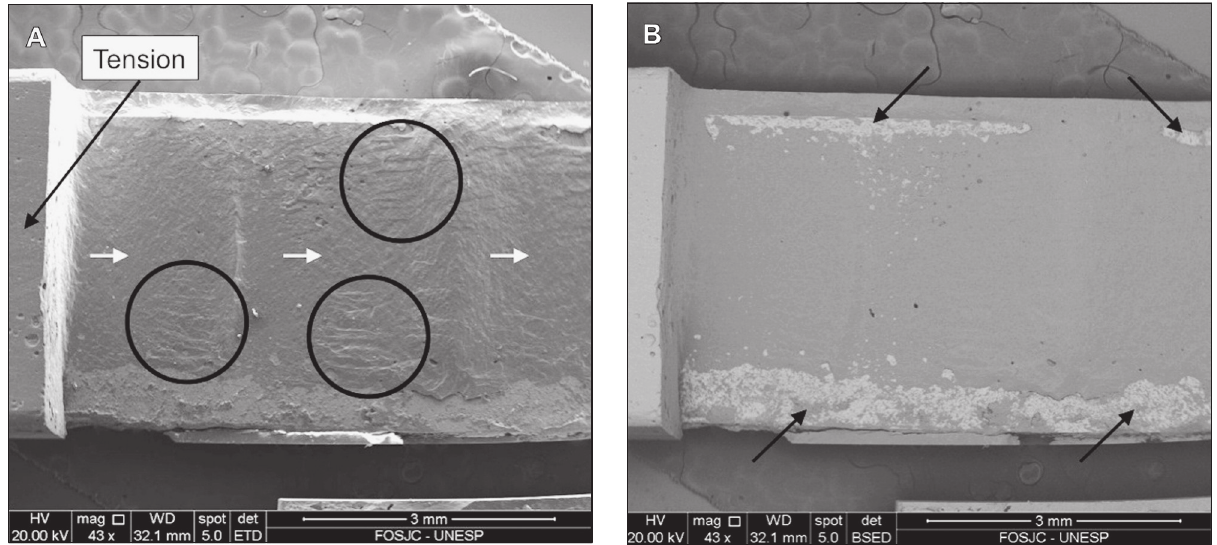
Figure 2 - A: Image of a control specimen showing cohesive failure and delamination of the porcelain (43 × ). The twist hackles displayed in the circles indicate the direction of crack propagation (white arrows). B: Image of a control specimen showing cohe- sive failure and delamination of the porcelain (43 × ). Delamination is observed close to the bar edges